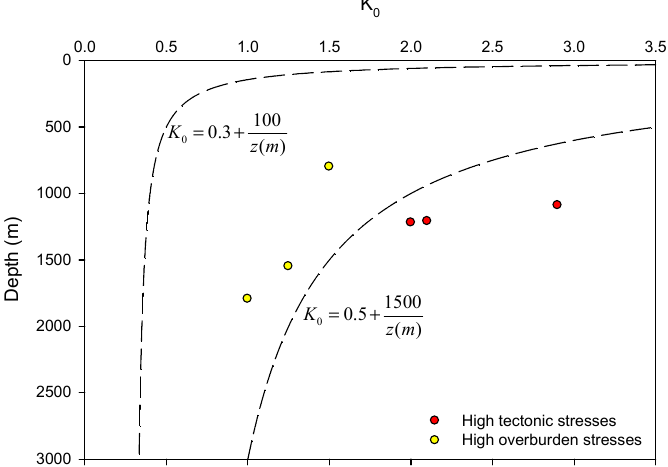
Figure 3. The ratio (K 0 ) between horizontal to vertical stress at various depths, z (m) of the NJHEP project area.